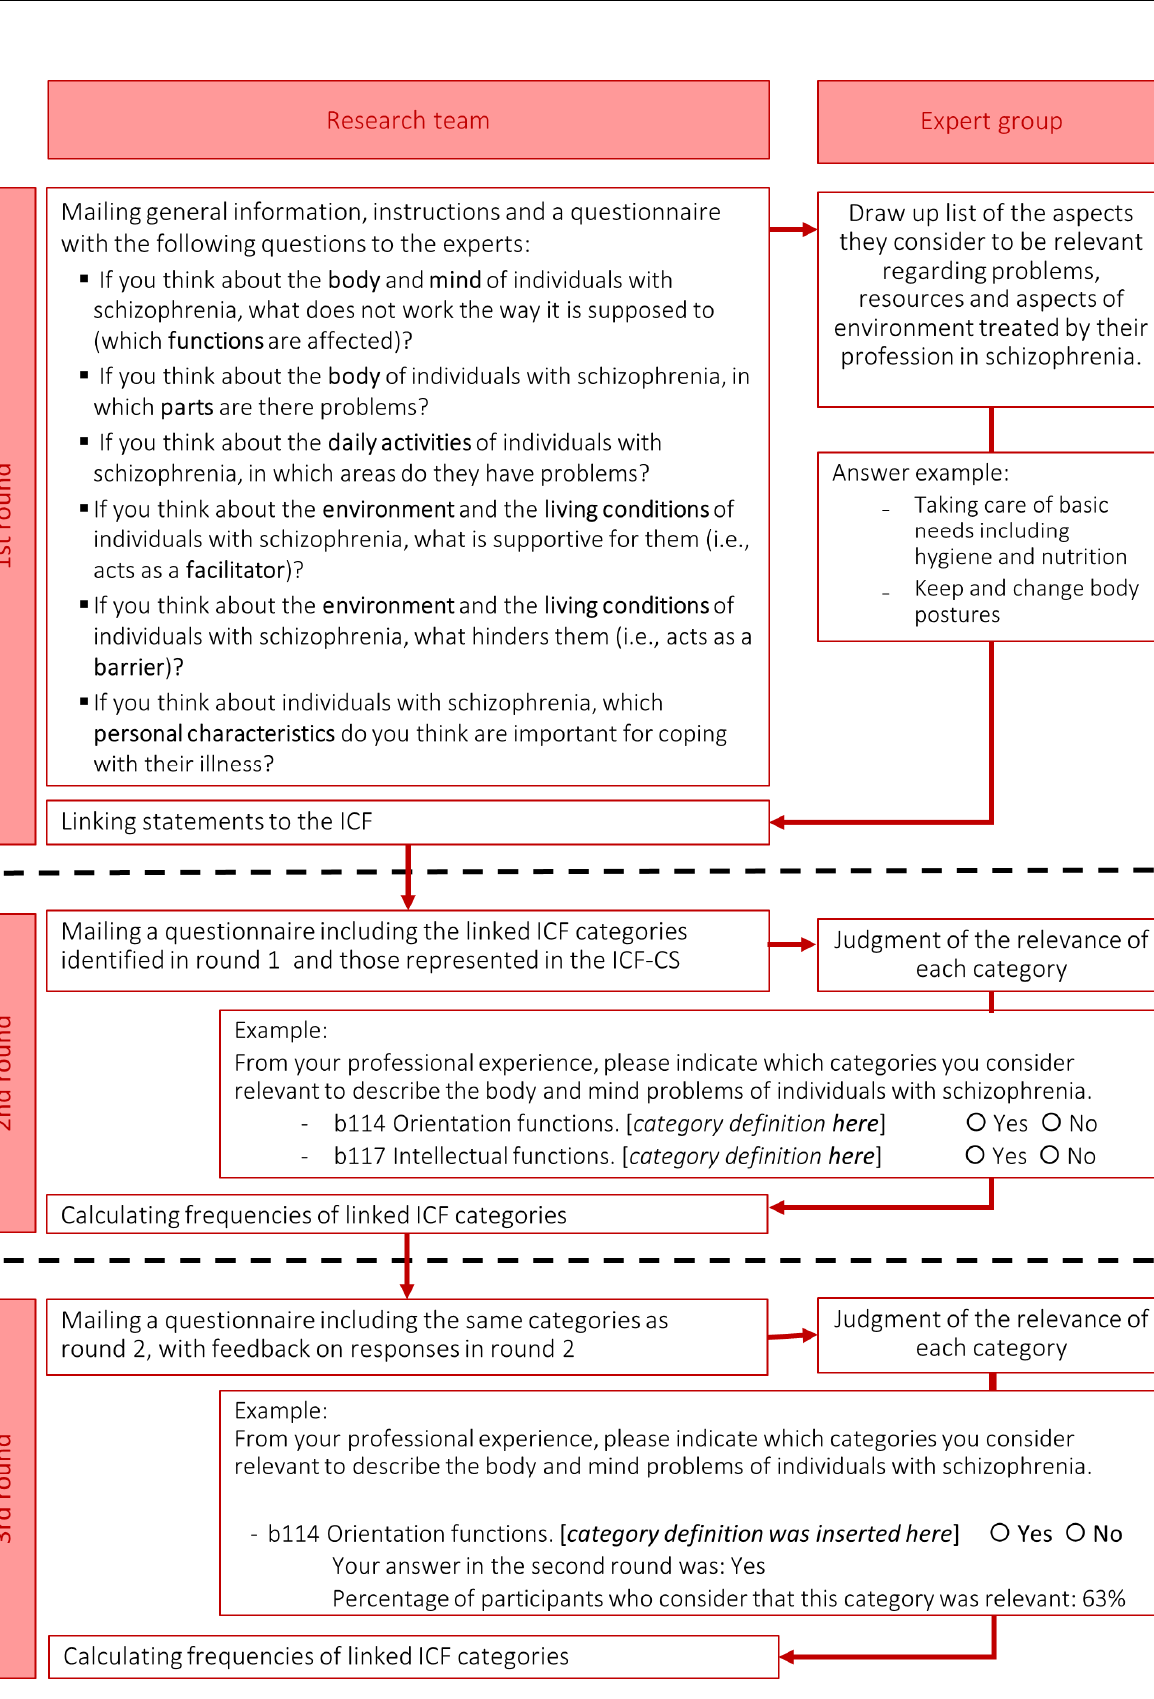
Figure 2. General procedure followed in each Delphi study.